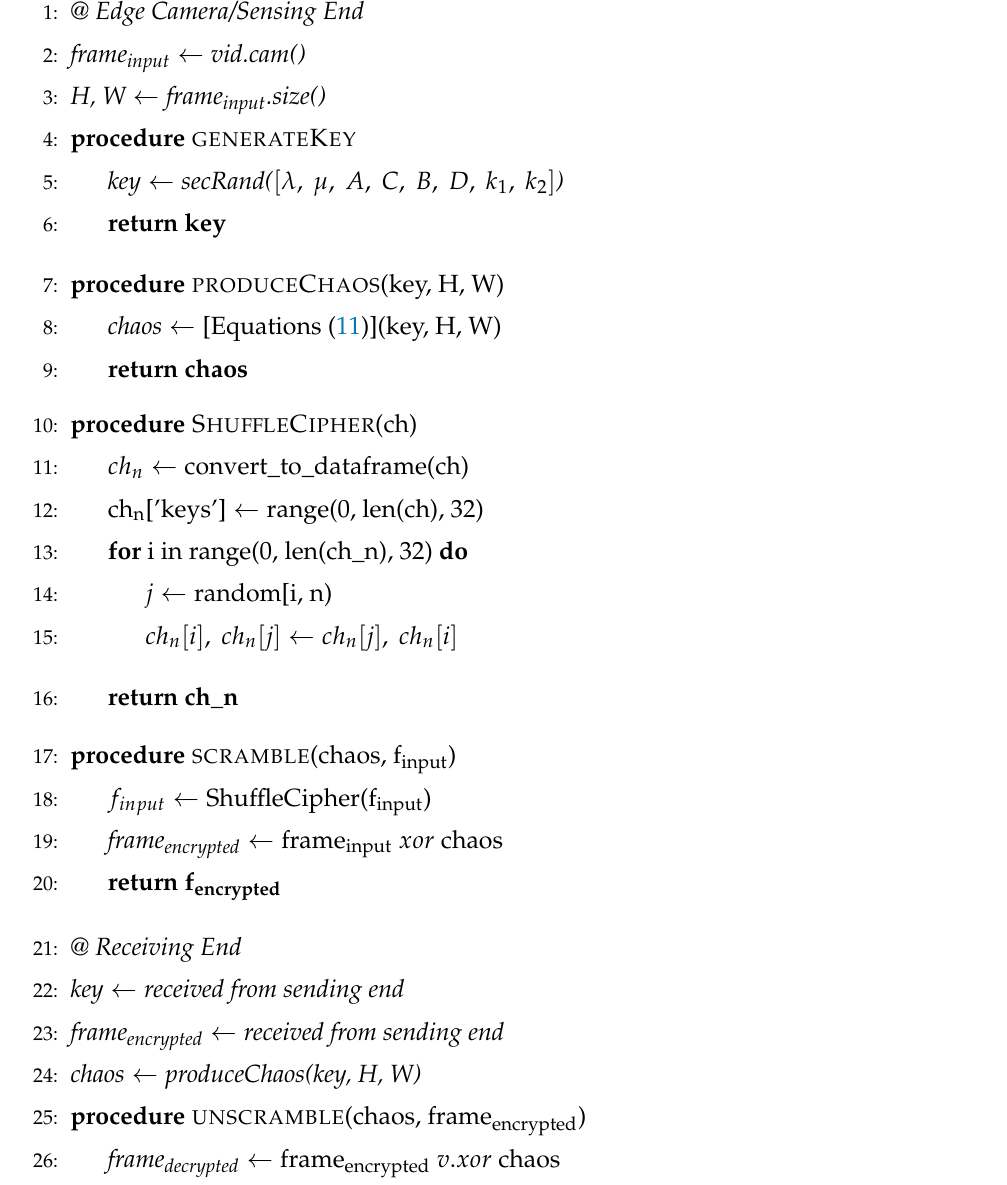
Algorithm 2 Frame Scrambling and its Inverse